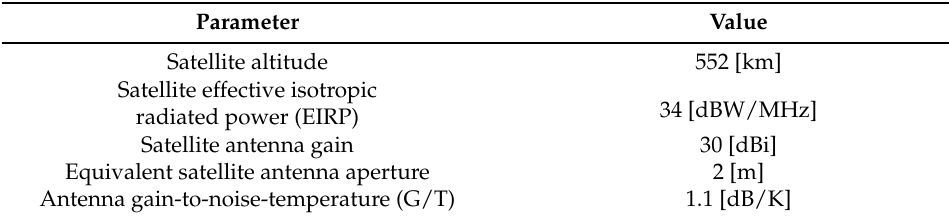
Figure 2. Architecture of the NB-IoT NTN. Table 2. LEO satellite parameters.